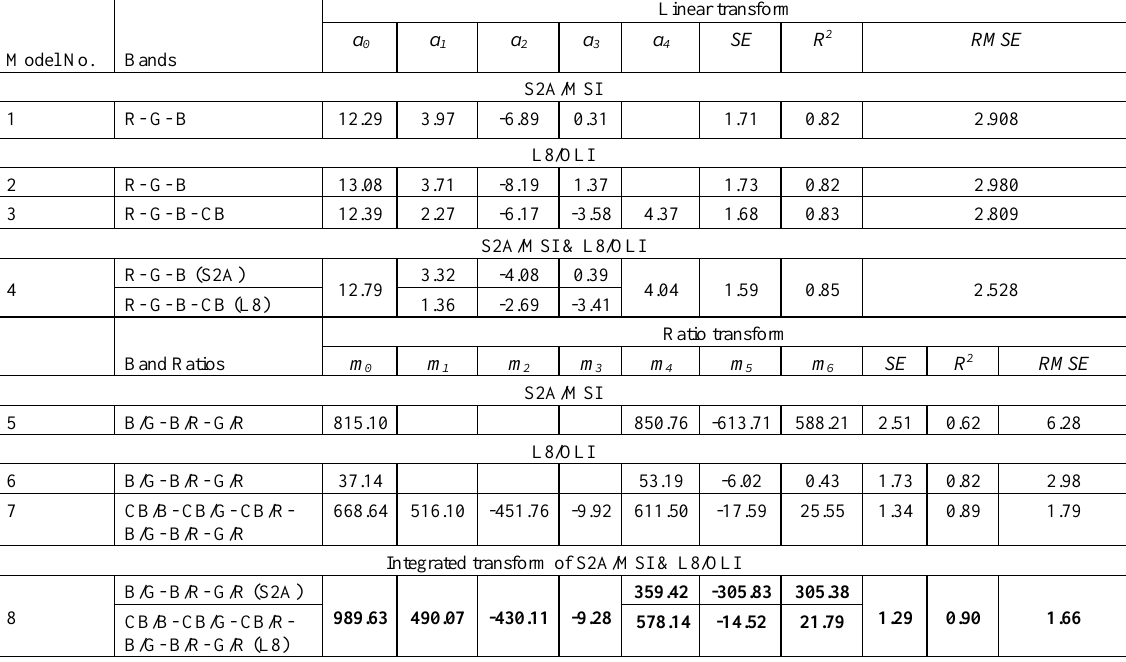
This contribution has been peer-reviewed. The double-blind peer-review was conducted on the basis of the full paper. https://doi.org/10.5194/isprs-annals-X-4-W1-2022-343-2023 | © Author(s) 2023. CC BY 4.0